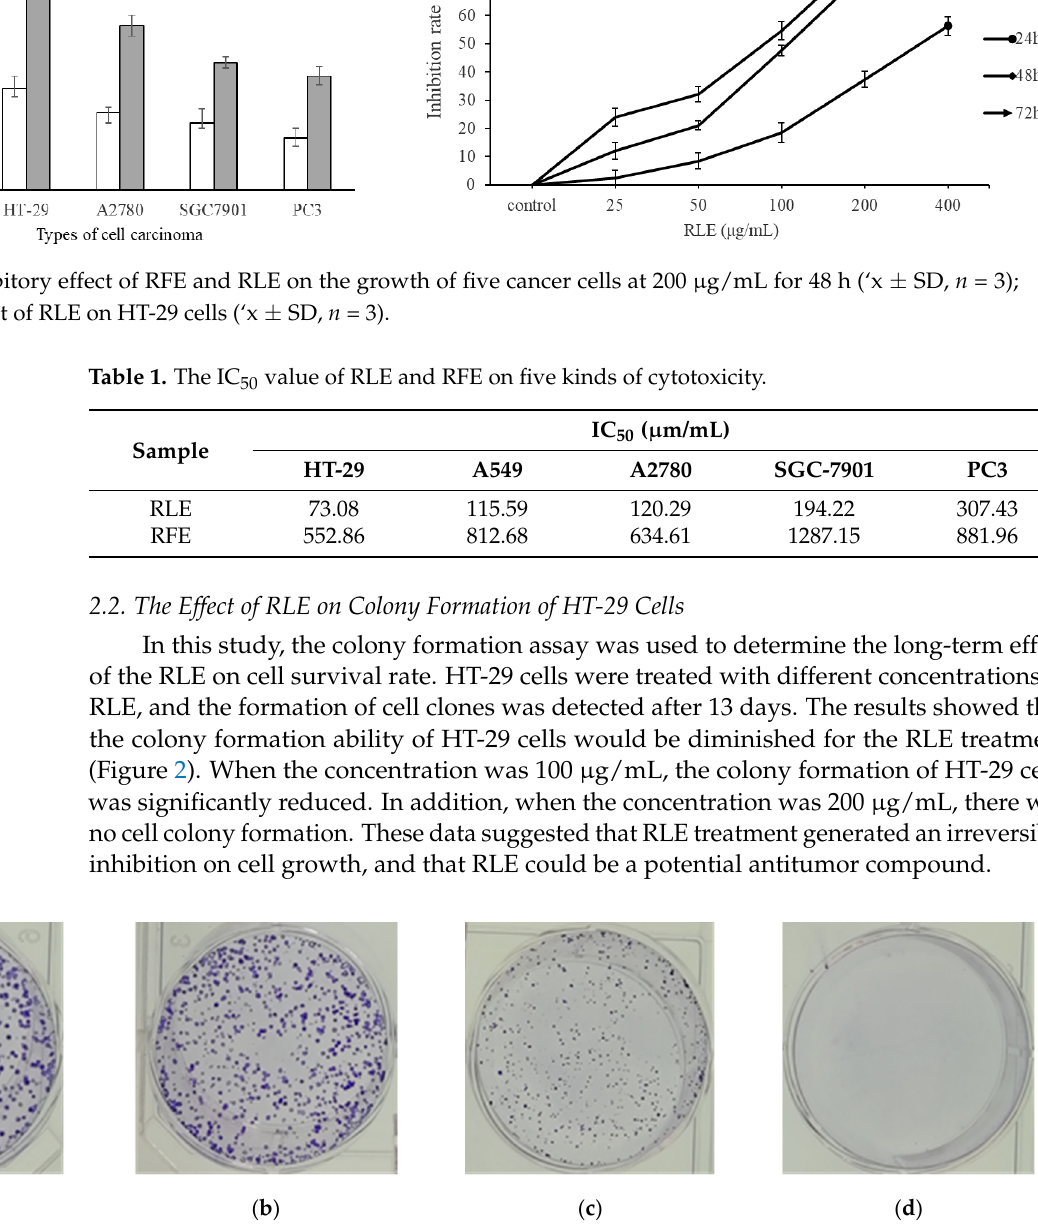
Figure 2. ( a ) Control; ( b ) 50 μ g/mL; ( c ) 100 μ g/mL; ( d ) 200 μ g/mL. The effect of RLE on the colony formation rate of HT-29 cells.